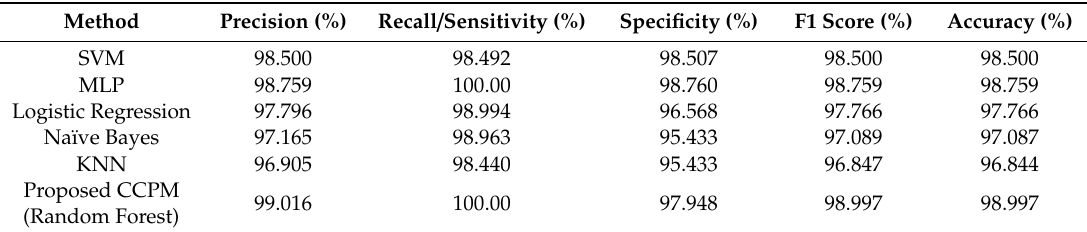
Table 14. Performance evaluation results based on DBSCAN and SMOTE for Hinselmann.